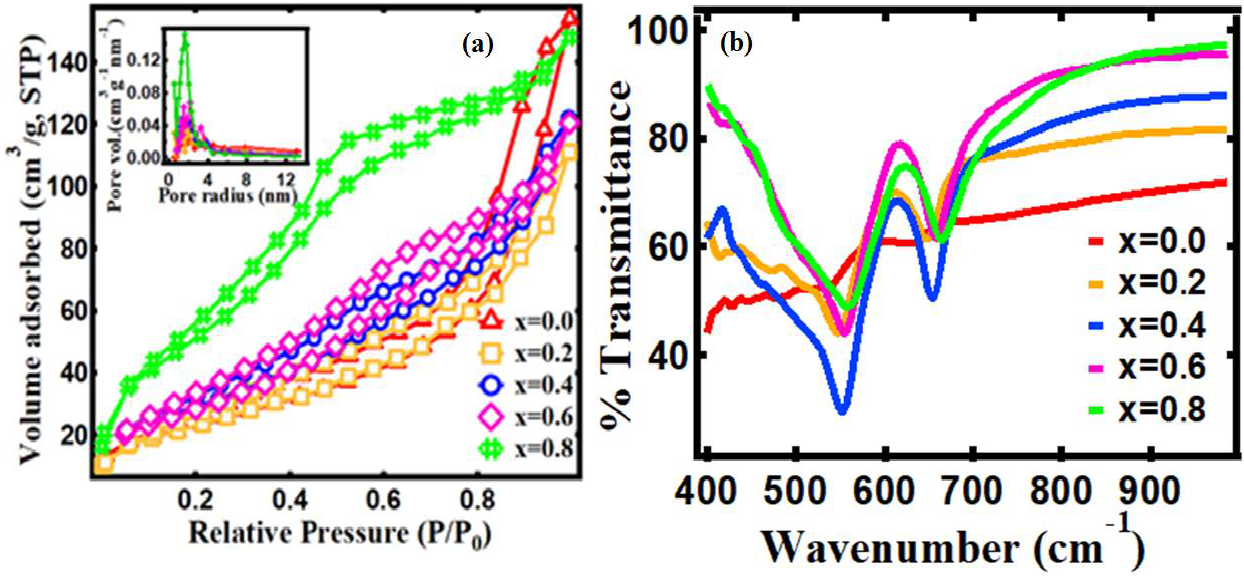
Figure 3. ( a ) Adsorption-desorption curves and inset pore volume distribution for Ni 1 − x Al x Co 2 O 4 , and ( b ) FTIR of Ni 1 − x Al x Co 2 O 4 .